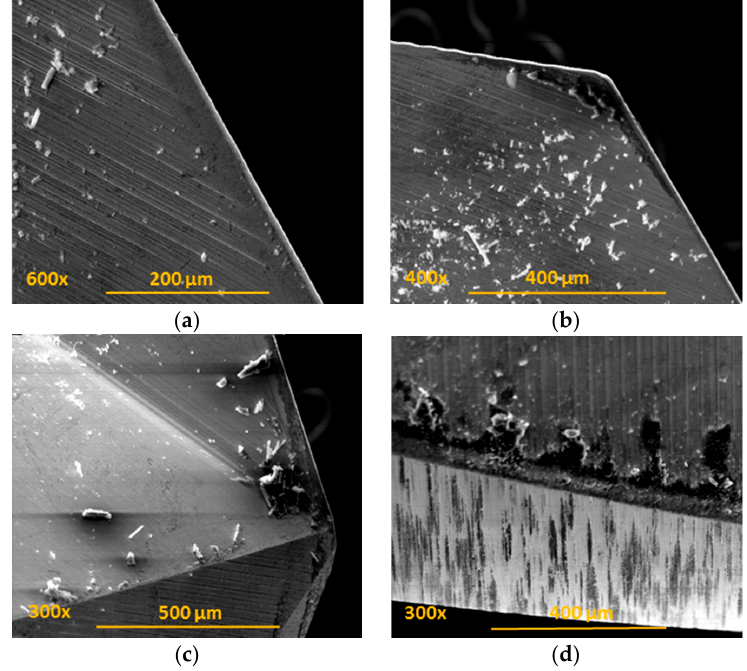
Figure 5. Location of drill wear by the abrasive action of carbon fibres: ( a ) main edge; ( b ) primary and secondary edge union; ( c ) tool tip; ( d ) peripheral face.